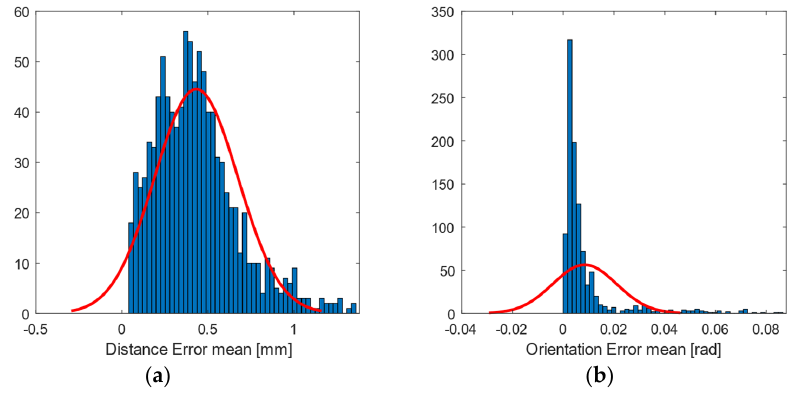
Figure 9. Histogram plot of the 97th percentile for mean error in ( a ) position (mm); and ( b ) orien- tation (rad). The red line represents a normal distribution as a comparison.